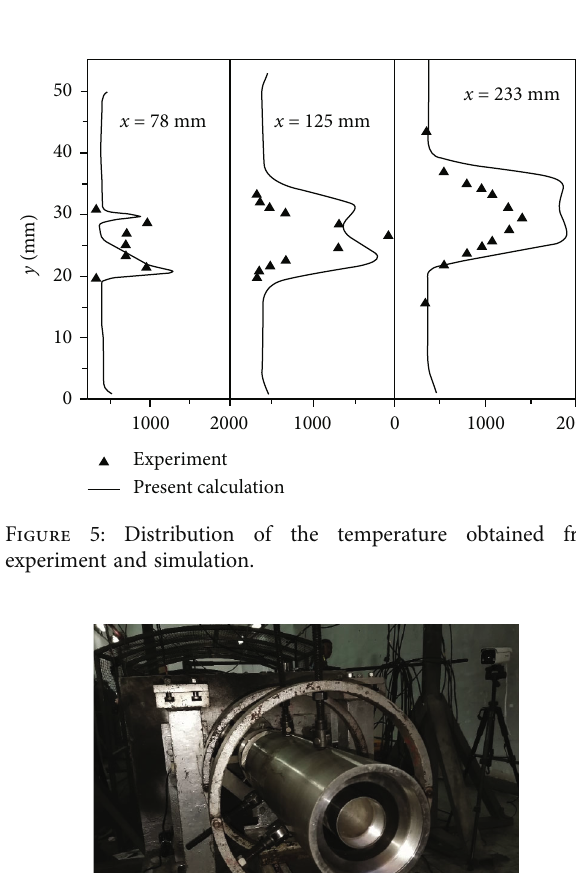
Figure 4: The schlieren interferogram obtained by experiment (up) and numerical simulation (down).